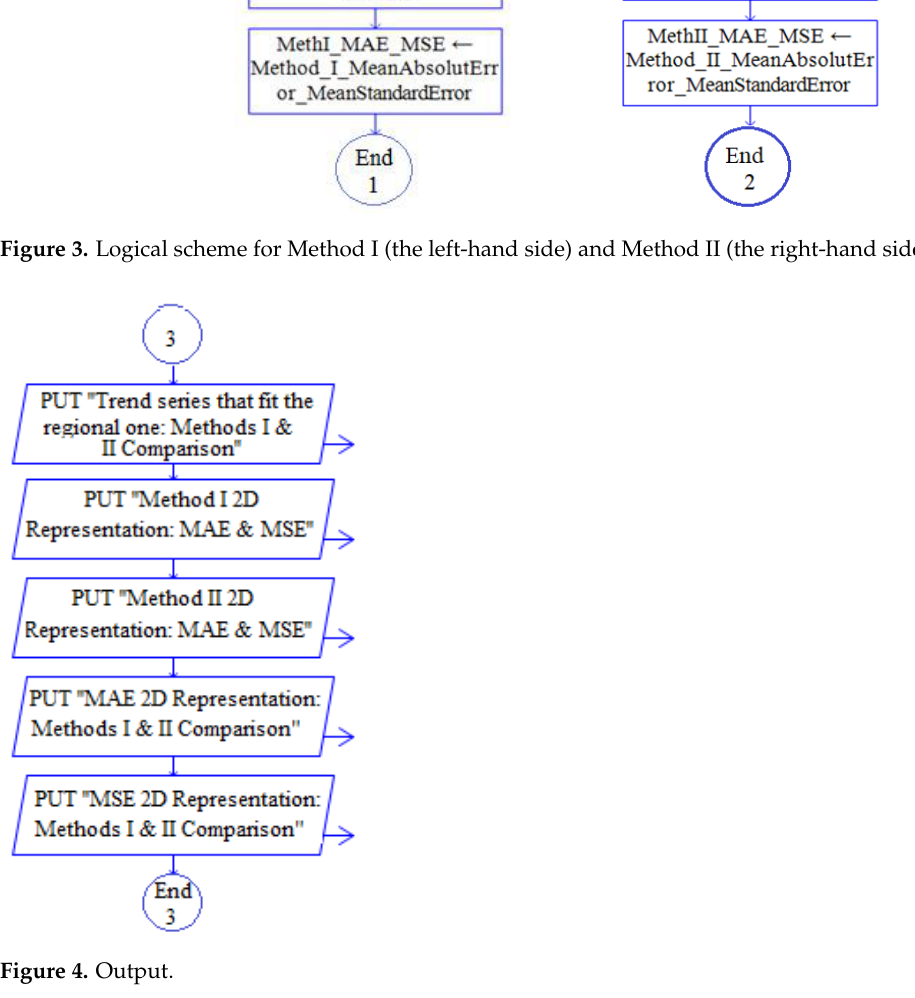
Figure 4. Output.